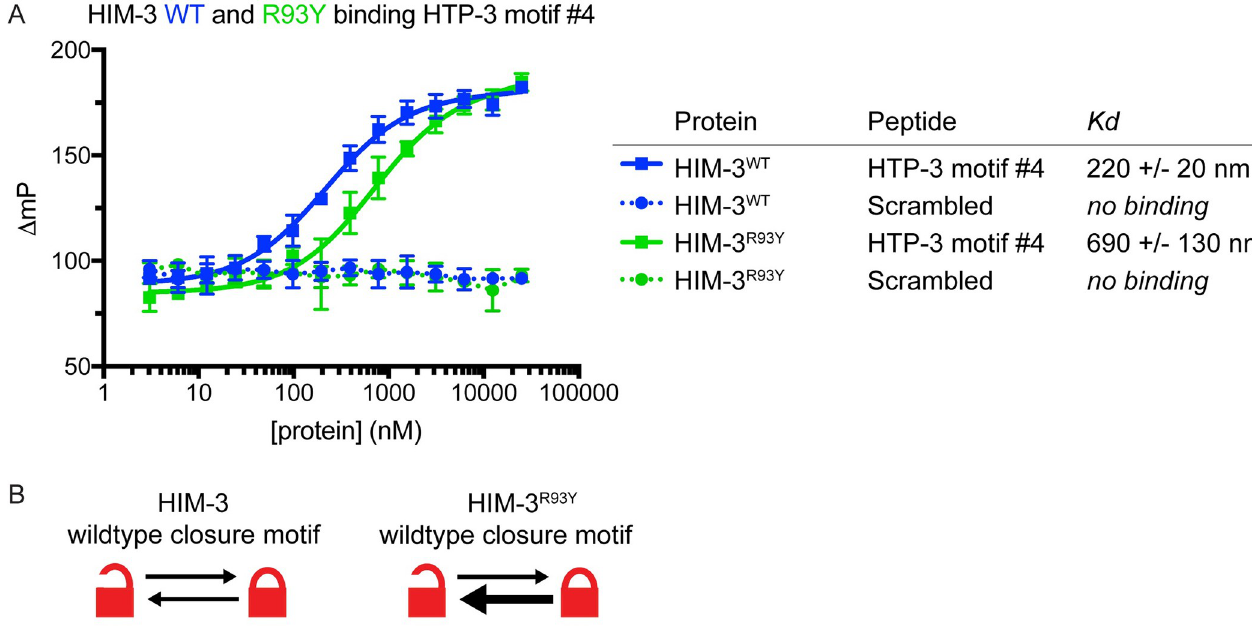
Fig 7. him-3 R93Y mutants have reduced affinity for closure motifs. A. Fluorescence polarization peptide binding assay of HIM-3 (blue) and HIM-3 R93Y (green) and measured Kd’s. B. Cartoon depicting proposed model for open and closed conformation switching of wildtype HIM-3 and HIM-3 R93Y